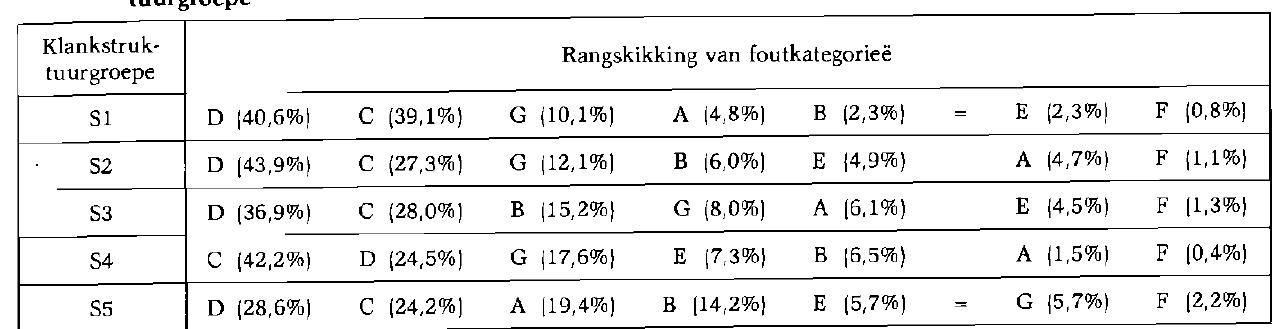
figure 1 en 2. Die afleidings wat op grond van die frekwen- sie-analise gemaak is, word deur die ooreenstemmingsanali-